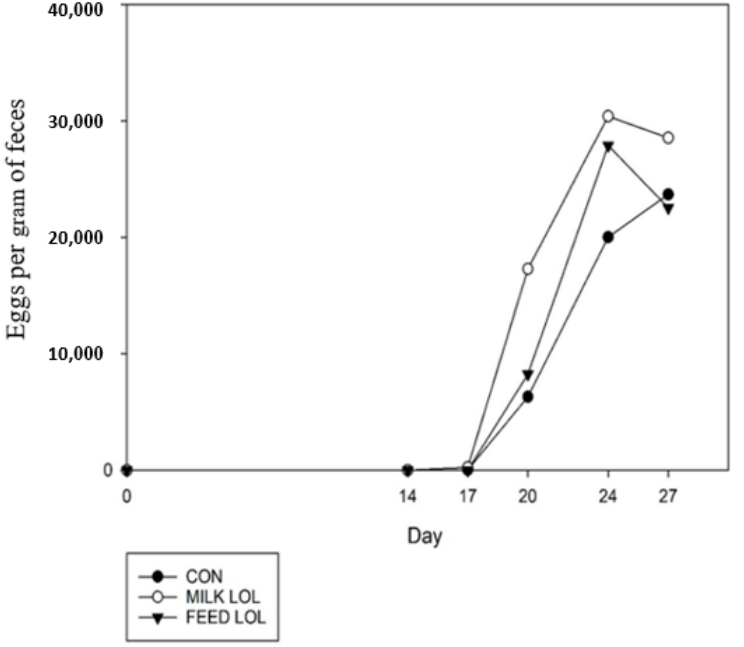
Figure 2. Average fecal egg counts of lambs infected with Haemonchus contortus treated with loline either orally or through milk or without .